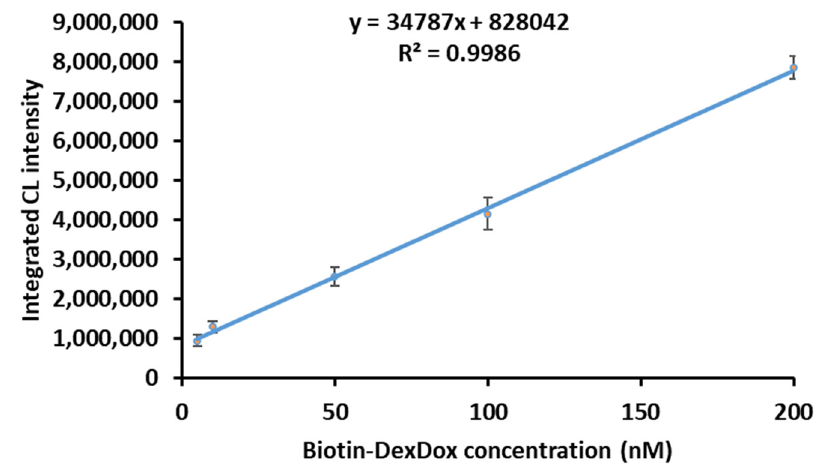
Figure 5. Calibration curve of Biotin-DexDox with the optimized CL conditions.